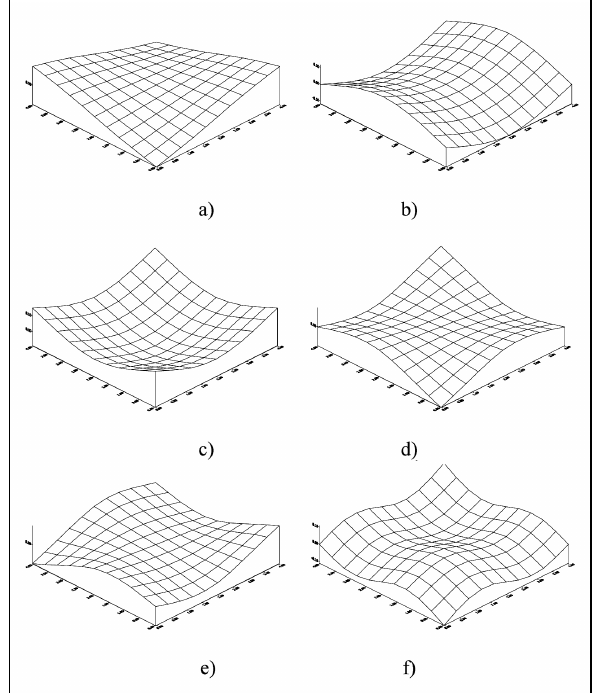
3 pav. Pirmosios šešios nenulinės formos Fig 3. The first six eigenvectors